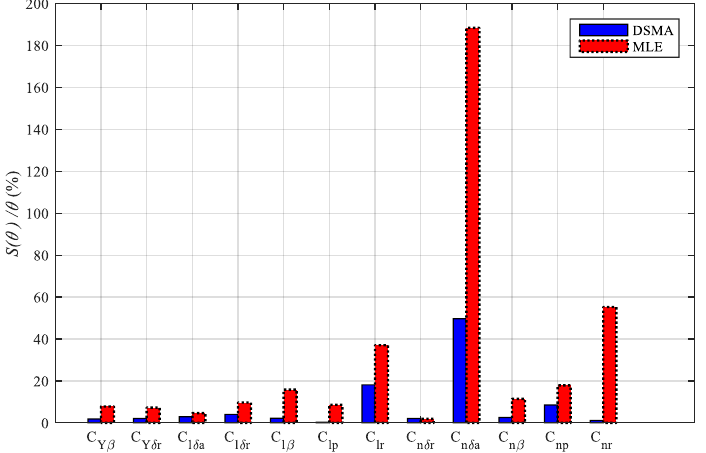
Figure 14. Dispersion coefficients of identification results.